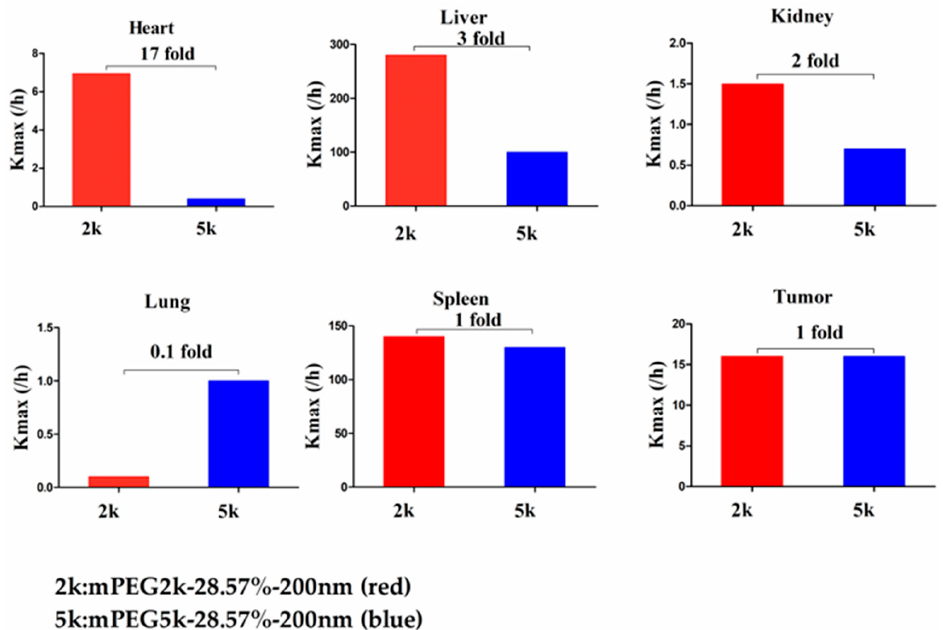
Figure 16. K max (/h) for mPEG5k-28.57%-200 nm (red) and mPEG2k-28.57%-200 nm NPs (blue).